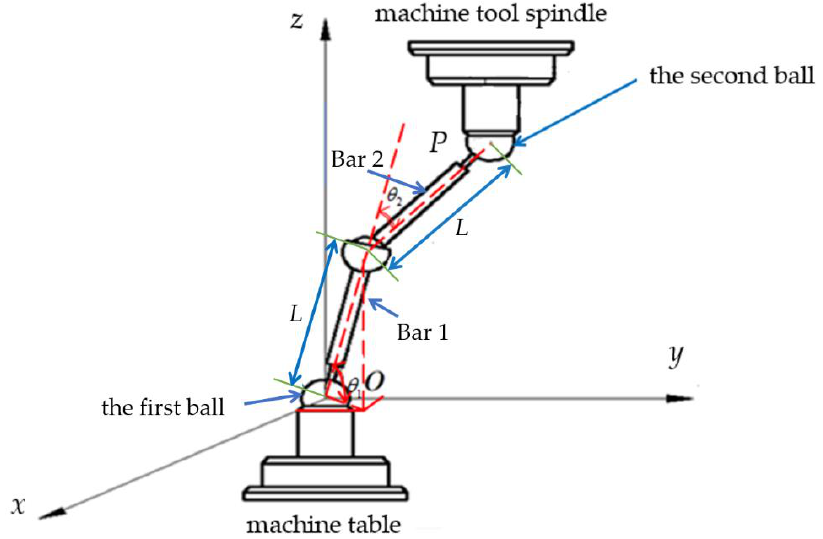
Figure 3. Measuring coordinates of the J-DBB.